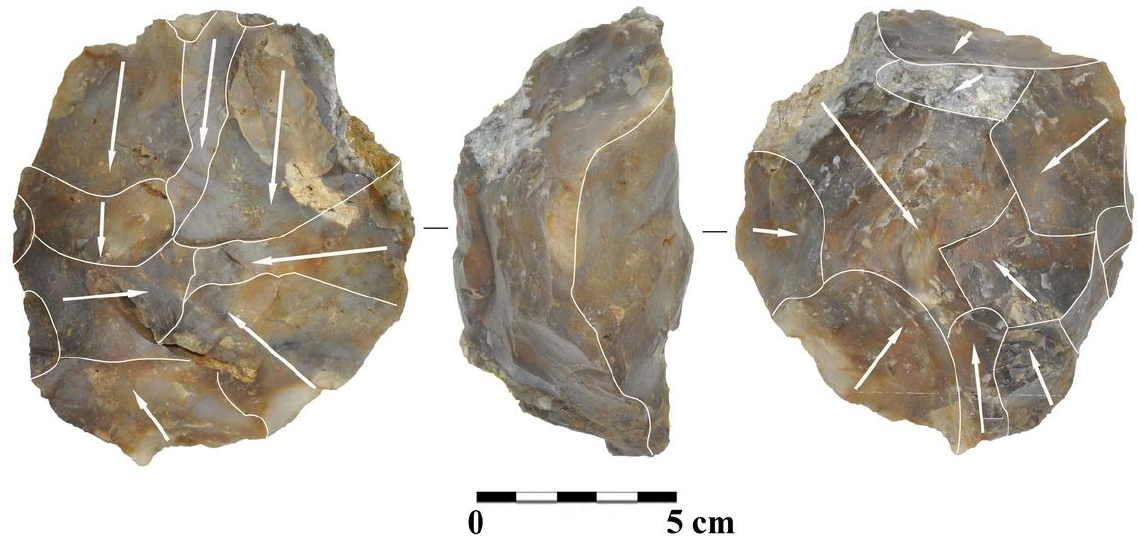
Figure 9. Lojanik 2, centripetal levallois